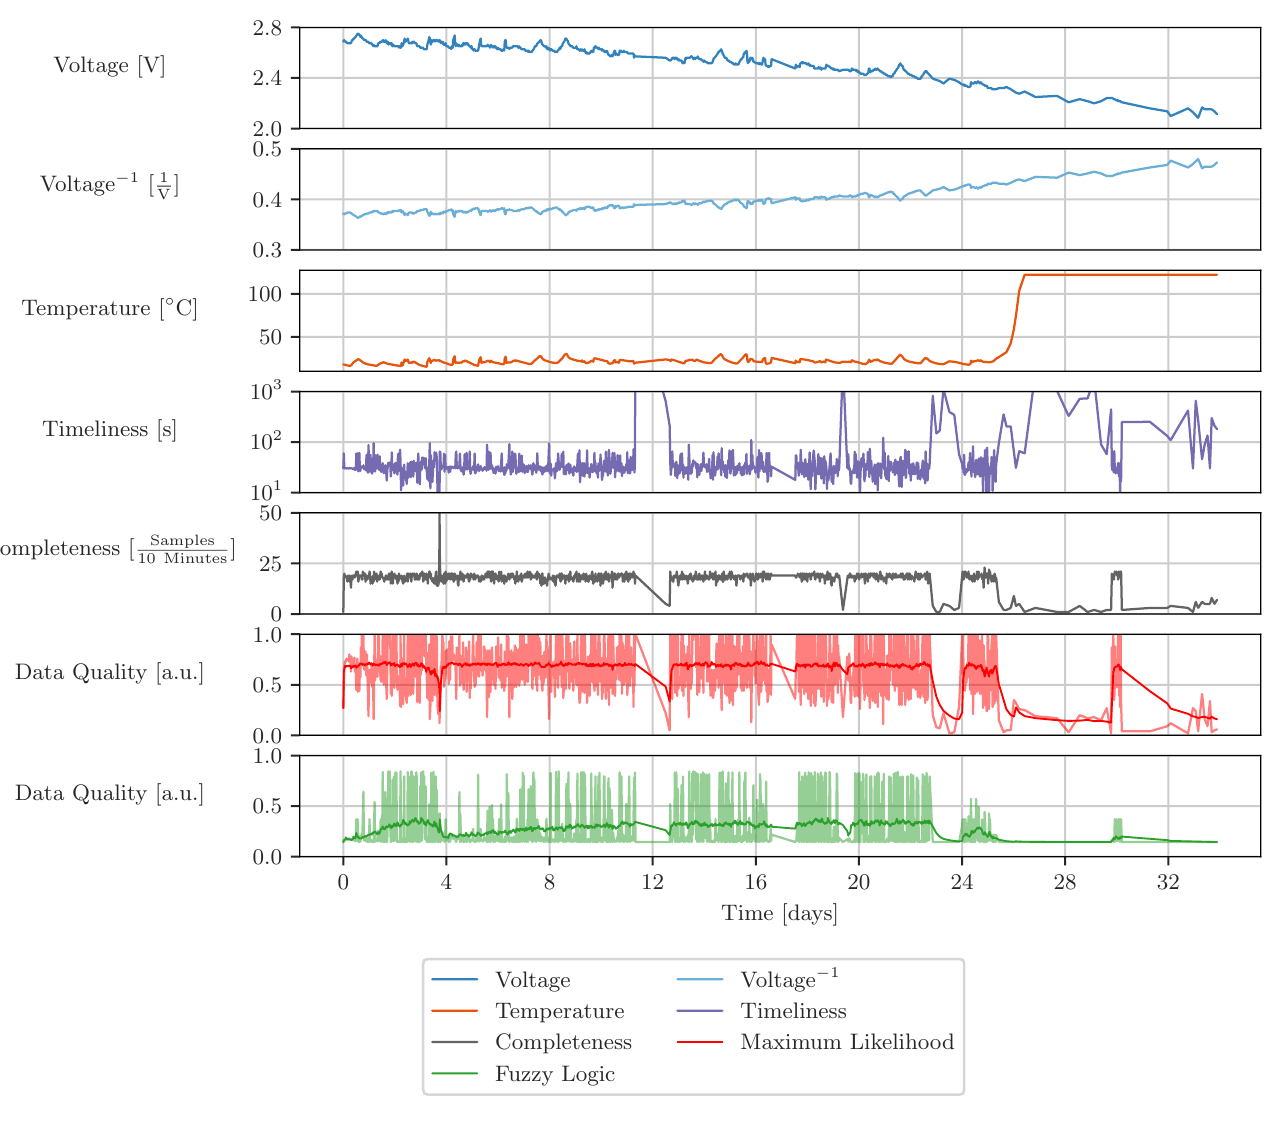
Figure A6. Intel Lab Data Mote ID 48, data quality attributes, measured values, and data quality